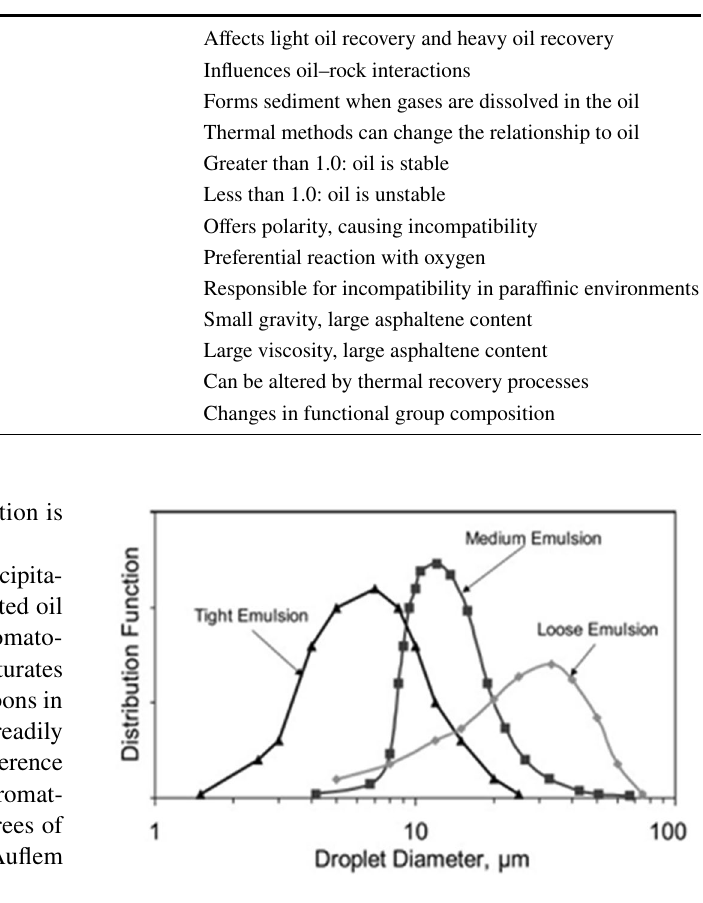
Fig. 2 Distribution function against droplet diameter (Kokal and Ara-